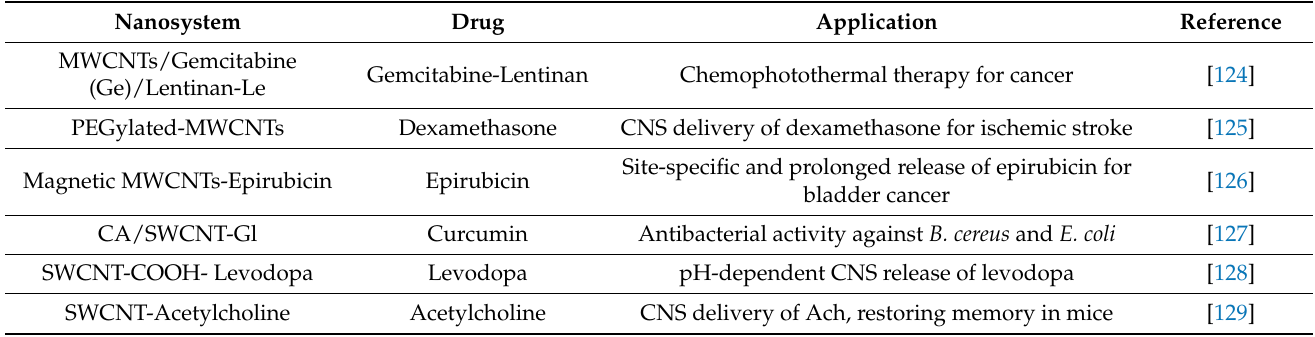
Table 6. Recent developments in CNT-based drug